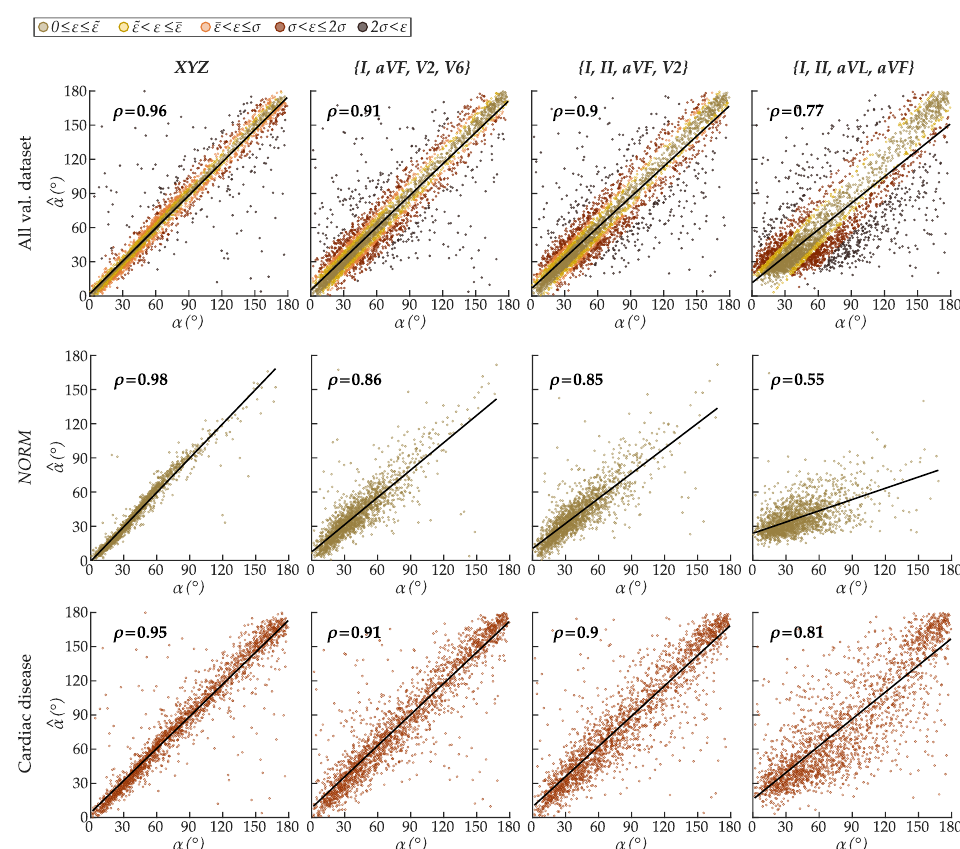
Figure 8. Scatter plot diagrams of the deep-learning-estimated (cid:98) α vs. target α from various sets of leads for ( top row ) all recordings, and ECGs with normal ( middle row ) NORM and ( bottom row ) cardiac disease in the validation dataset. The estimation error (cid:101) of every (cid:98) α in the first row is color-grouped based on the absolute median (˜ (cid:101) ), mean ( (cid:101) ), and standard deviation ( σ (cid:101) ) error.